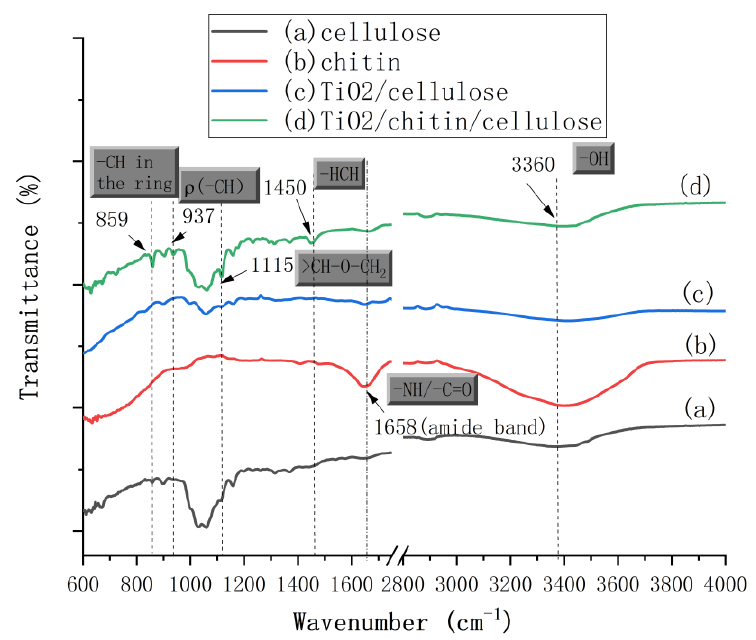
Figure 5. FT-IR spectra curves of the 3D-printed photocatalysts composed of (a) cellulose (5 g) (black), (b) chitin (red), (c) TiO 2 (0.3 g)/cellulose (5 g) (blue), and (d) chitin (2 g)/cellulose (5 g) (green).